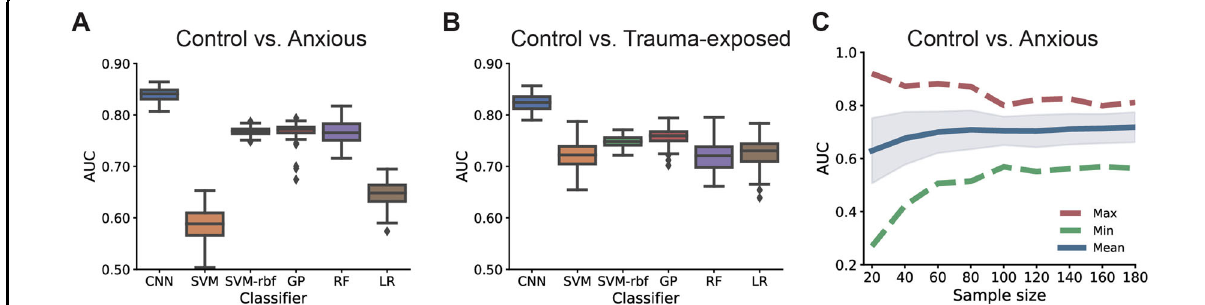
Fig. 5 AUCs derived from different classi fi ers and different sample size. A The cross-validated AUC statistic derived from our proposed CNN was better than the other fi ve tested classi fi ers in Control vs. Anxious and B Control vs. Trauma-exposed. C Small sample size resulted in large standard deviations of classi fi cation accuracies. CNN convolutional neural network, SVM support vector machine with linear kernel, SVM-rbf SVM with Gaussian radial basis function (RBF) kernel, GP Gaussian process classi fi er with RBF kernel, RF random forest, LR logistic regression with L2 regularization. Box plots show the AUC statistics derived from 100 random selections in 5-fold